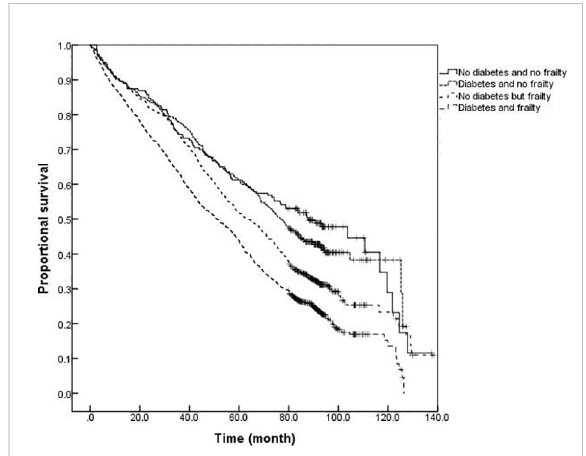
FIGURE 6 Kaplan-Meier curves for the proportional survival of older adults aged ≥ 80 years with different diabetes and frailty